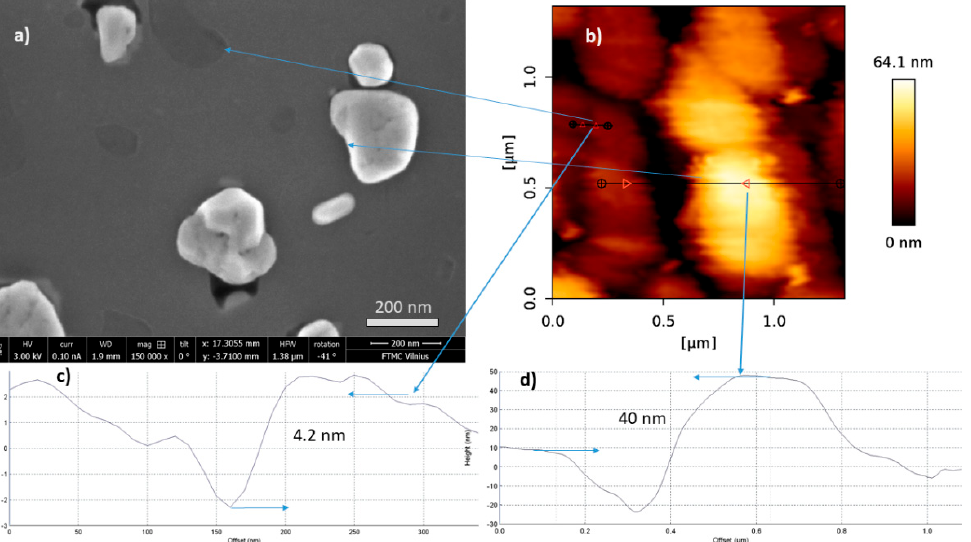
Figure 10. SEM ( a ) and AFM ( b ) images and profilograms ( c , d ) of the graphene synthesized using a two-step process, measured after the etching of the cobalt film. The thickness of the Co layer was 25 nm, ion beam treatment temperature—400 °C, annealing temperature—700 °C, ion beam energy—800 eV, ion beam treatment time—15 min.